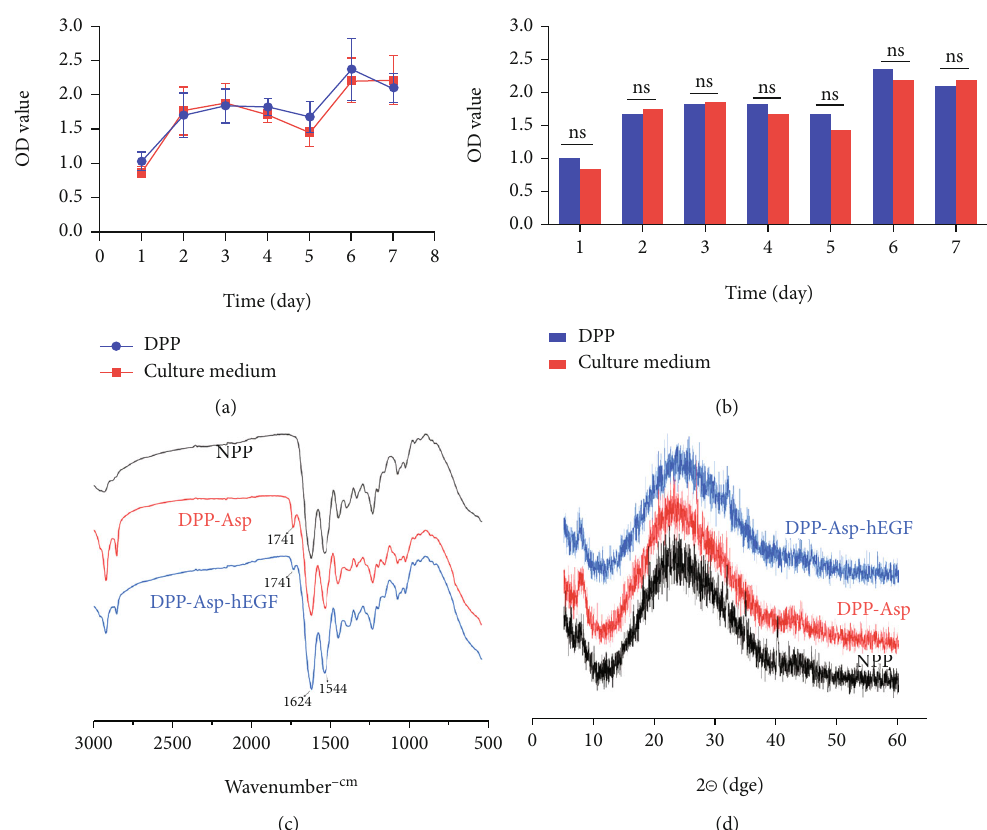
Figure 4: In vitro cytocompatibility of the DPP and e ff ect of crosslinking. (a, b) CCK-8 analysis of cells on DPP extract and culture medium for 7 consecutive days after seeding. (c) Peaks of FTIR spectra of DPP, crosslinked Asp, and crosslinked Asp-hEGF. (d) XRD patterns were collected from the above